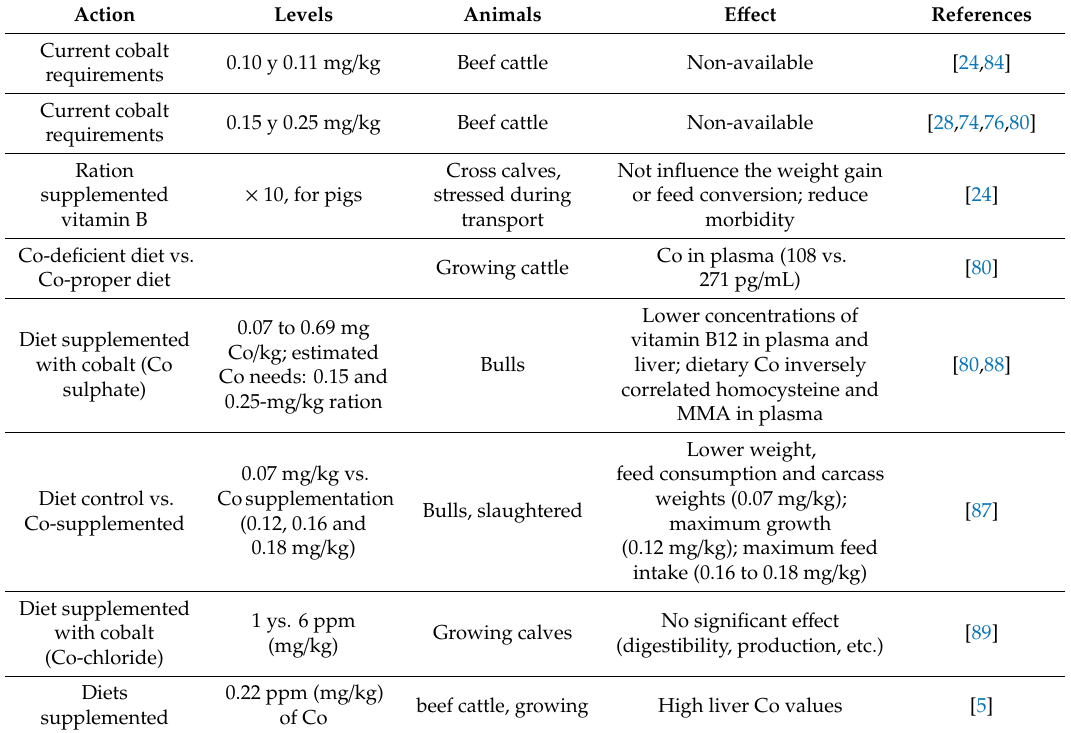
Table 2. Some experiences about a supplementation with Co / vitamin B12 in feedlot and its most representative e ff